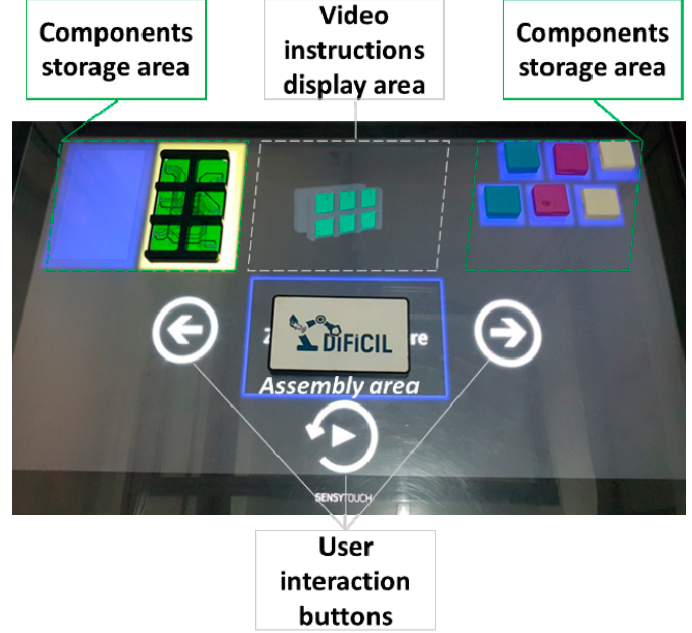
Figure 2. The user interface of the assembly assistance system.